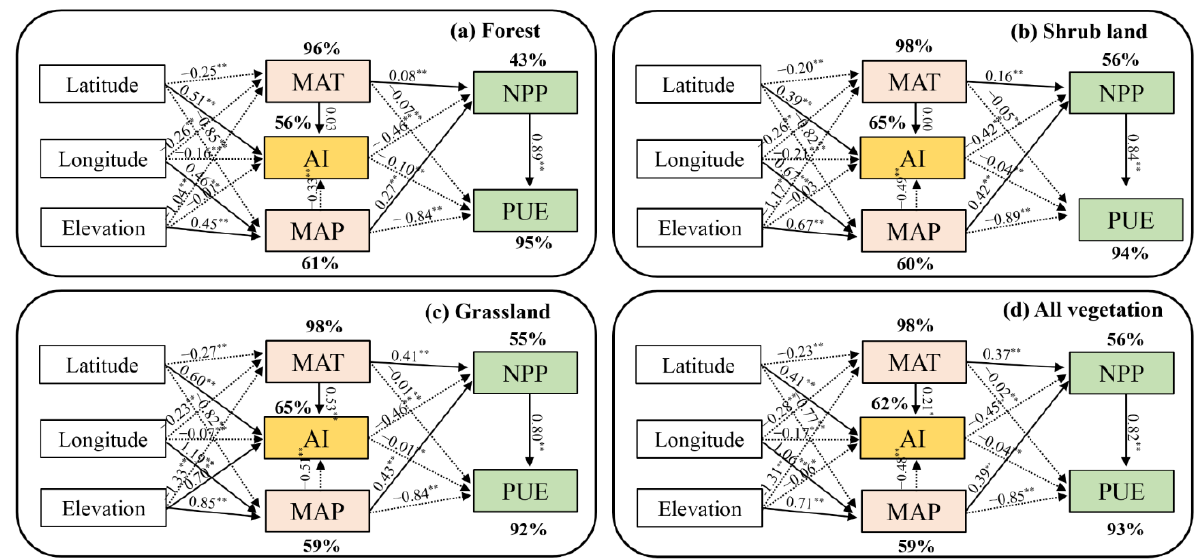
Figure 6. SEMs of geographic factors (Latitude, longitude, and elevation) and climate factors (MAP, MAT, and AI) on spatial variation of NPP and PUE for forest ( a ), shrub land ( b ), grassland ( c ), and all vegetation ( d ). Solid and dashed arrows represented the positive or negative effects in fitted SEMs, respectively. The * and ** represented a significant relationship at p < 0.05 and p < 0.01, respectively.